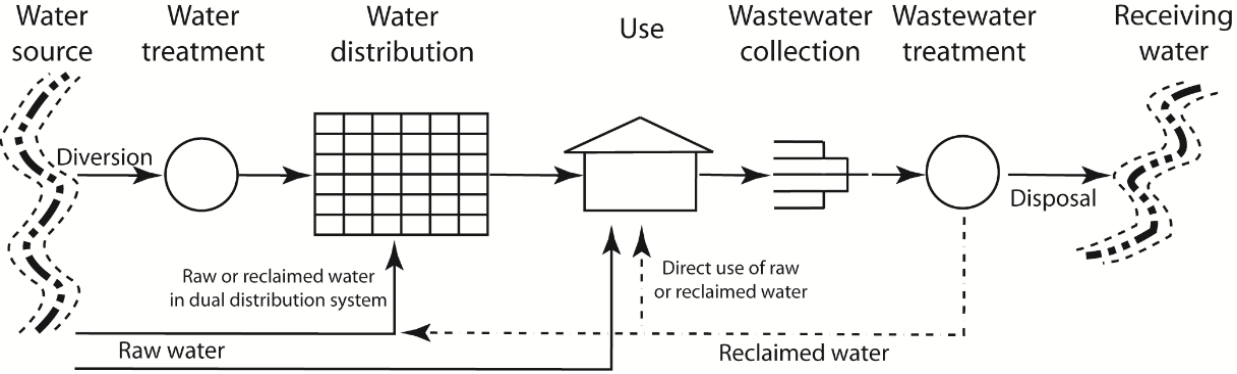
Figure 1. The urban water